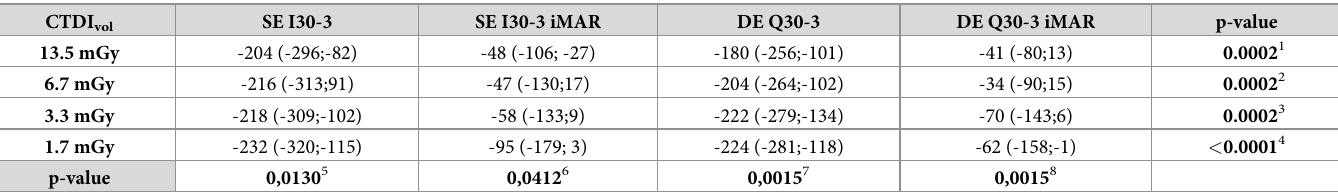
Table 2. HU values at the liver parenchyma adjacent to the trocar tip (LIVER-1) with median and 1st and 3rd percentiles in brackets. CTDI